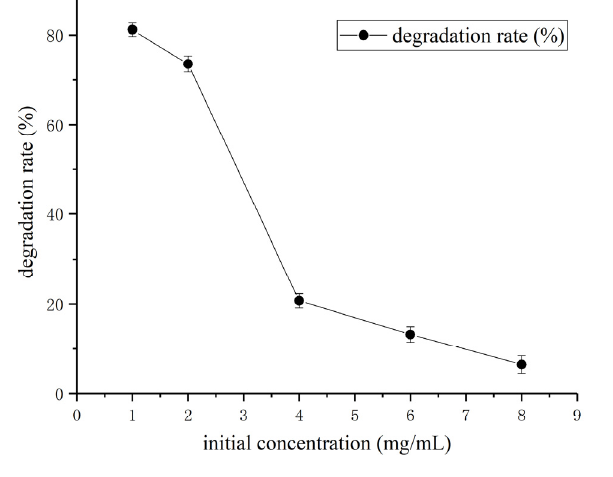
Figure 5. Effect of initial coumarin concentration on coumarin degradation rate. The results are expressed as the mean ± SD from three independent experiments.